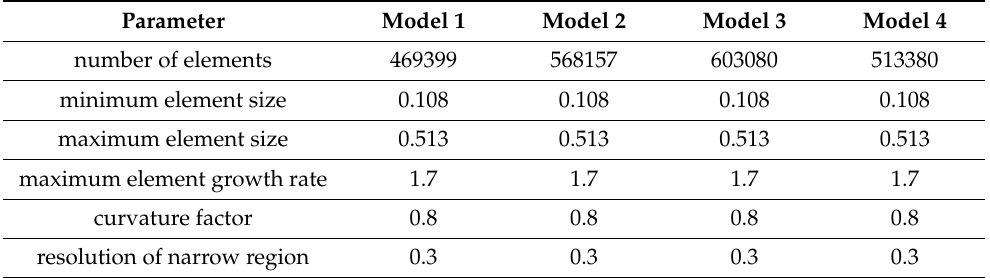
Table 2. Parameters of the mesh .